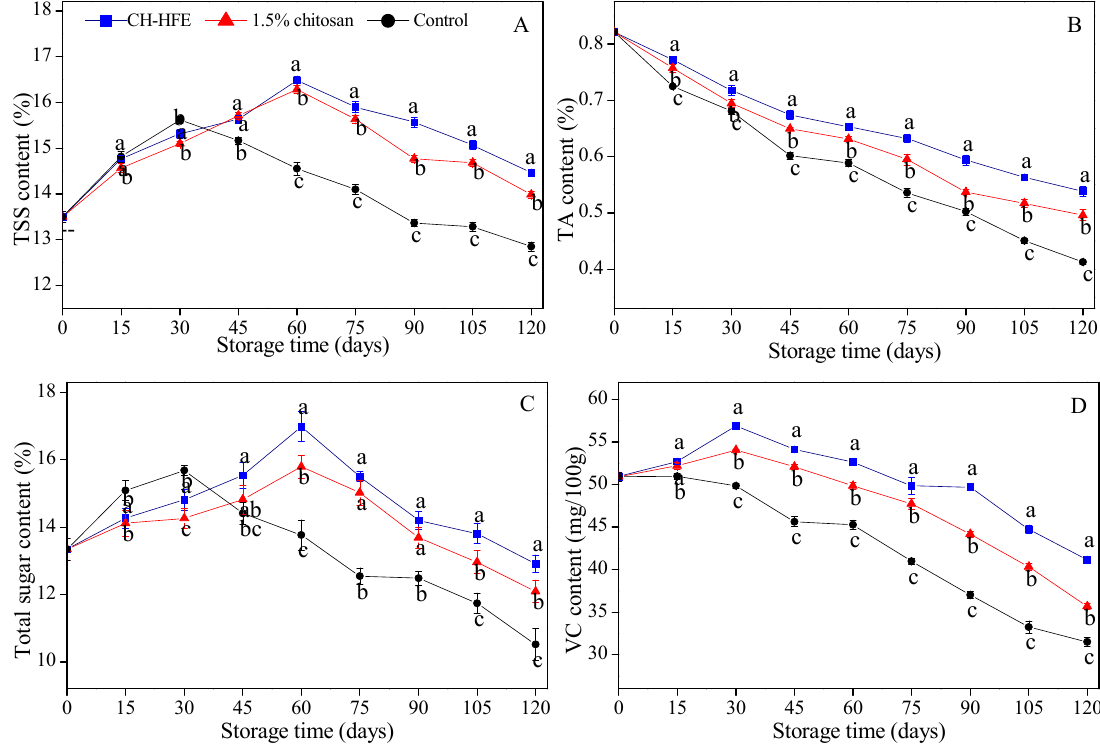
Figure 3. Changes in total soluble solid (TSS) ( A ), titratable acid (TA) ( B ), total sugar ( C ), and vitamin C (VC) content ( D ) of navel orange fruits stored at 5 °C for 120 days. Each value represents the mean ± SE of three replicates, each consisting of 30 randomly selected fruits.